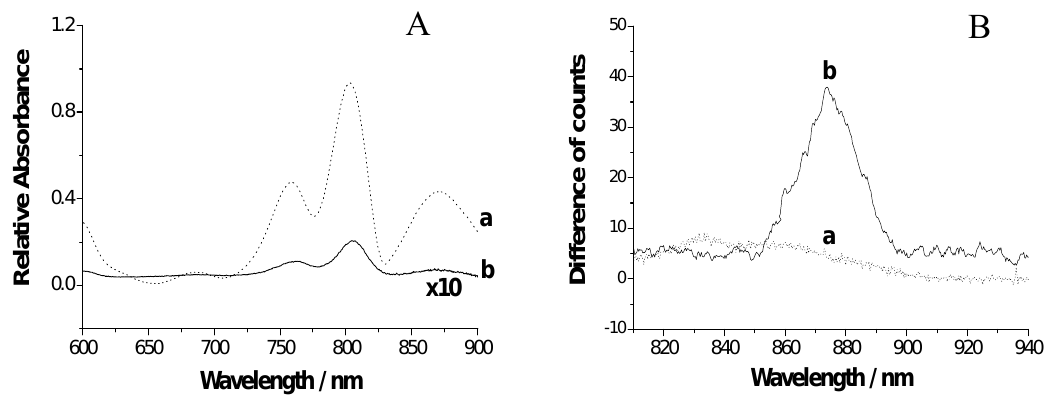
Figure 2. Steady absorption spectra and fluorescence emission spectra of the RC/TiO 2 composite film. (A) NIR-visible absorption spectra of 4 µ M RC in the pH 8.0 film (b, solid line). Absorption Tris-HCl buffer (a, dotted line) and the RC/ TiO 2 of the bare TiO film was subtracted as background. (B) Fluorescence emission 2 spectra of the RC-free TiO film (a, dotted line) and the RC/TiO film (b, solid 2 2 line) at 293 K, excited at 800 nm and detected at 870